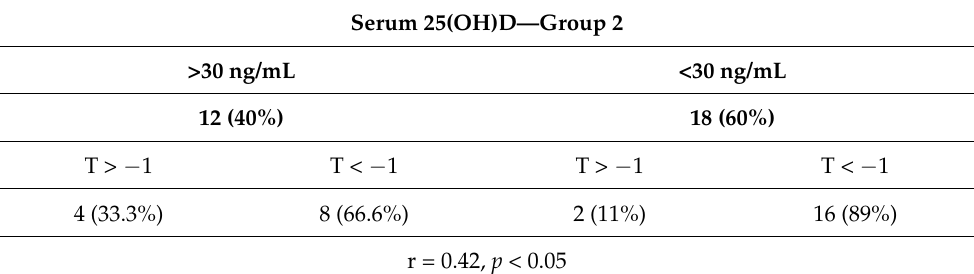
Table 8. The prevalence of BMD T-score alterations in patients with normal and decreased levels of serum 25(OH)D (group